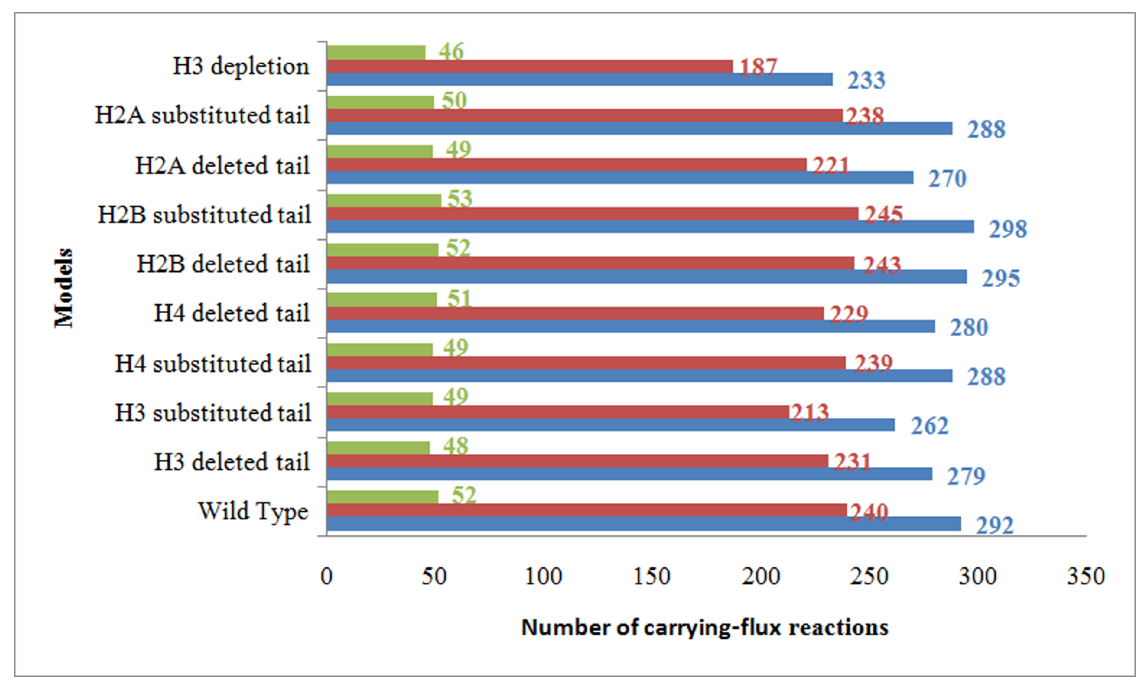
Figure 5. Comparison of the number of all, positive and negative carrying-flux reactions (blue, brown and green bars, respectively) in all constructed GSMMs.